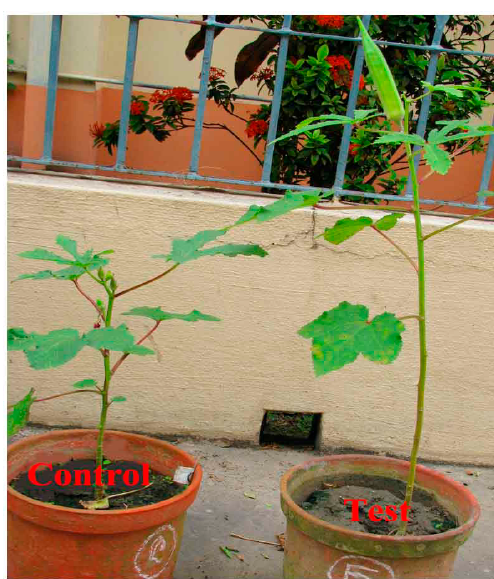
Fig. 4. Shoot height difference of 30 days old biofertilizer treated Abelmoschus esculentus test plant (right) against biofertilizer untreated control plant (left)